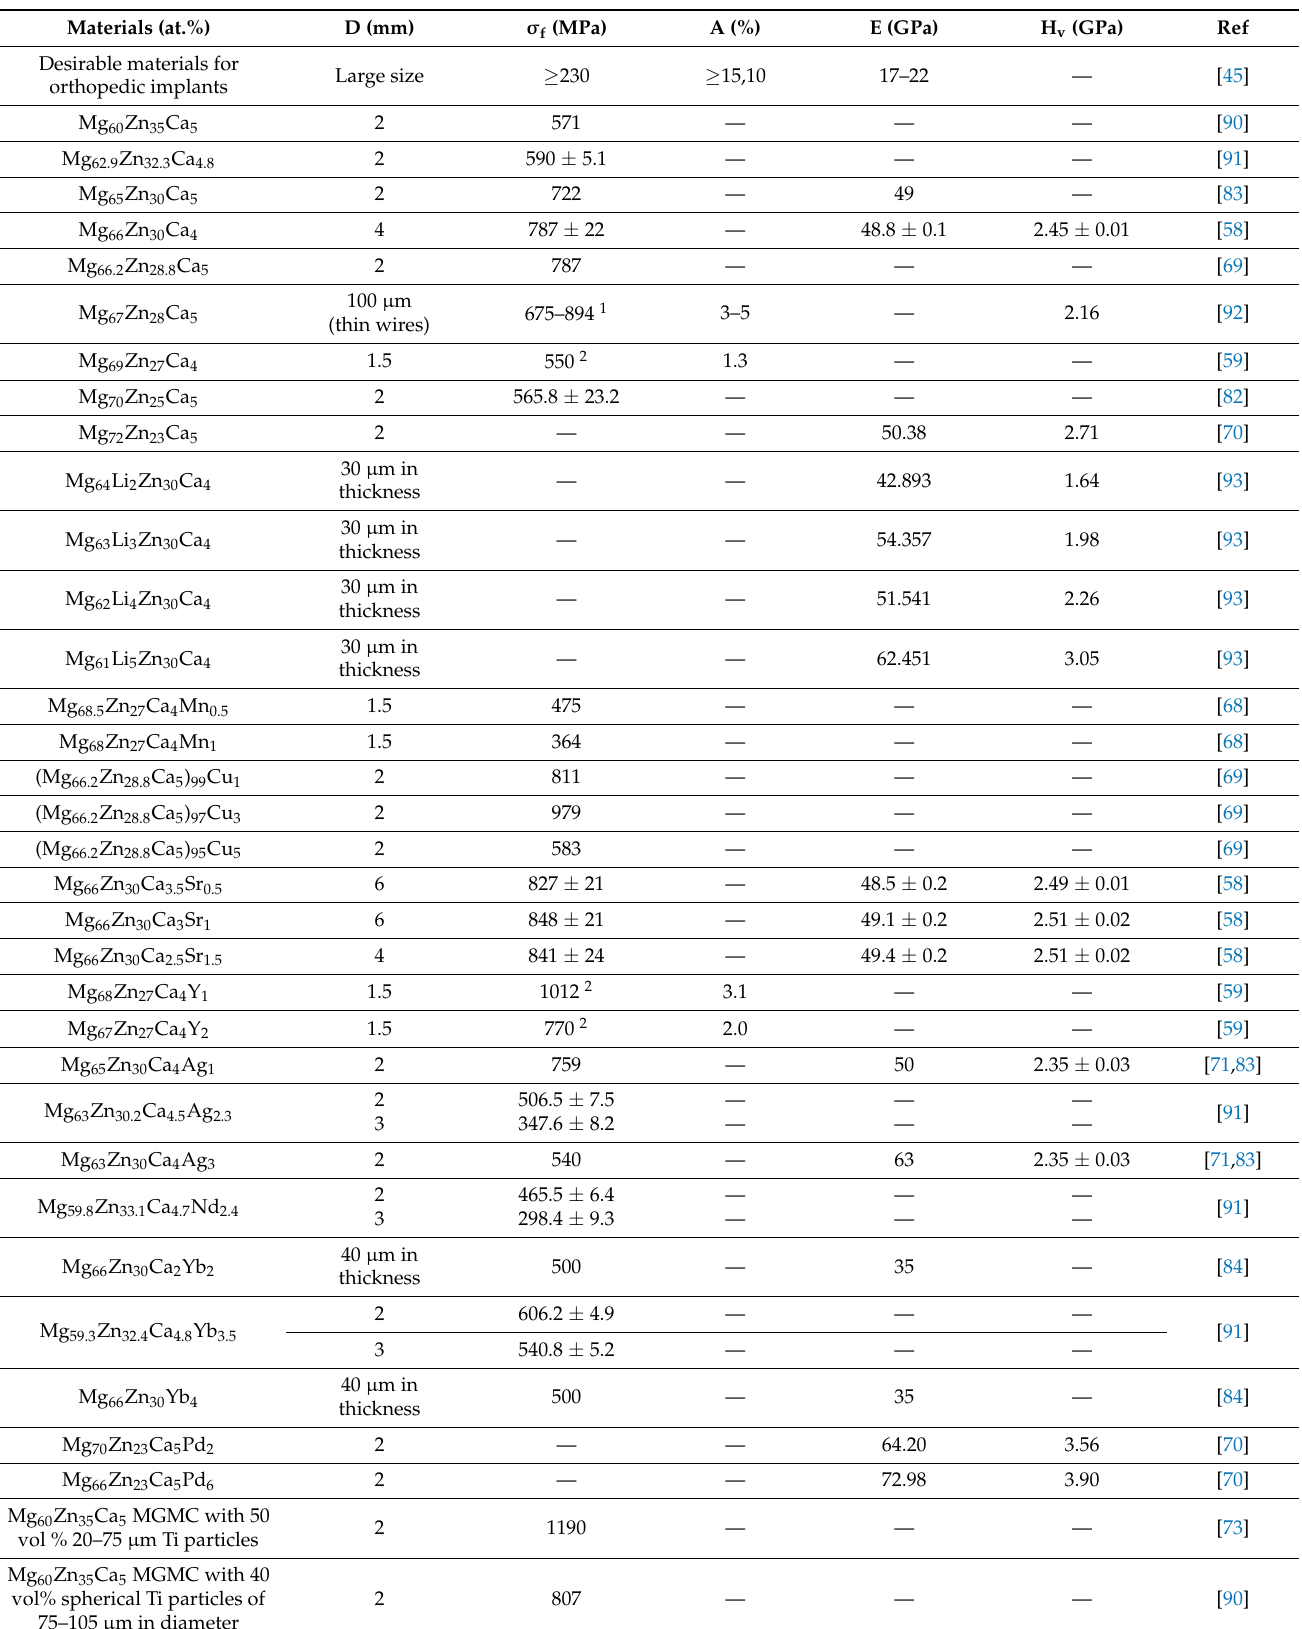
Table 2. Mechanical properties of Mg–Zn–Ca-based